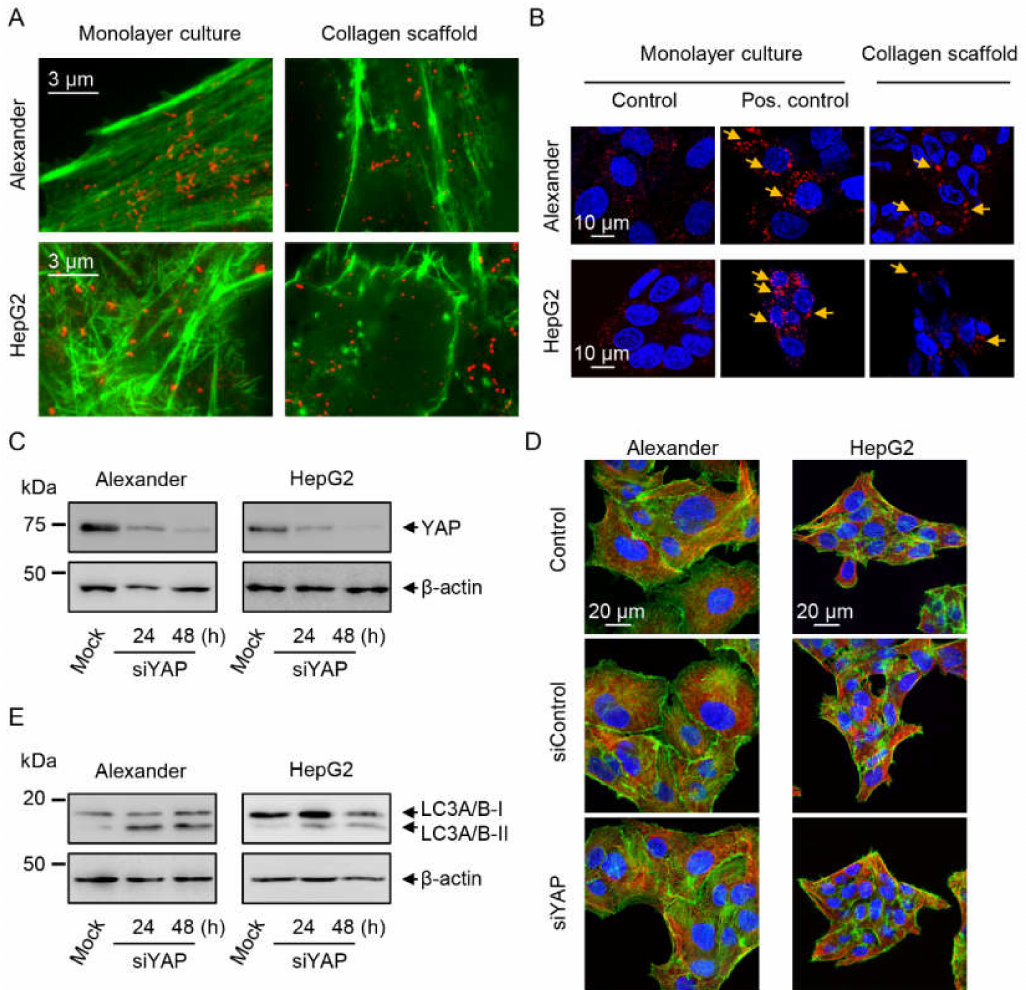
Figure 6. Autophagic flux in cells cultured in collagen sca ff olds. ( A ) IXplore SpinSR Olympus super-resolution microscopy of F-actin staining (green) and pmTOR (red). ( B ) Assessment of cellular autophagosome punctae containing LC3-II by confocal microscopy. HepG2 and Alexander cells were grown either in standard monolayer culture or in collagen sca ff olds. Cells were fixed and immunostained for nucleus (blue) and LC3 (red). Labeled cells were then imaged using confocal microscopy. Arrows indicate formation of cellular autophagosome punctae. Positive control—serum starvation for 14 h (Alexander cells) and treatment with 10 mM H 2 O 2 for 30 min (HepG2 cells). ( C ) Downregulation of YAP. Immunoblot analysis for YAP in Alexander and HepG2 cells transfected with YAP siRNA for 24 and 48 h; β -actin—control of equal protein loading. ( D ) Immunostaining analysis for F-actin (green) and tubulin (red) in Alexander and HepG2 cells transfected with YAP siRNA for 48 h. Hoechst 33342 (blue) dye was used to counterstain nuclei. Labeled cells were then imaged by confocal microscopy and the images were processed using ImageJ software (NIH). ( E ) Immunoblot analysis for LC3 in Alexander and HepG2 cells transfected with YAP siRNA for 24 and 48 h; β -actin—control of equal protein